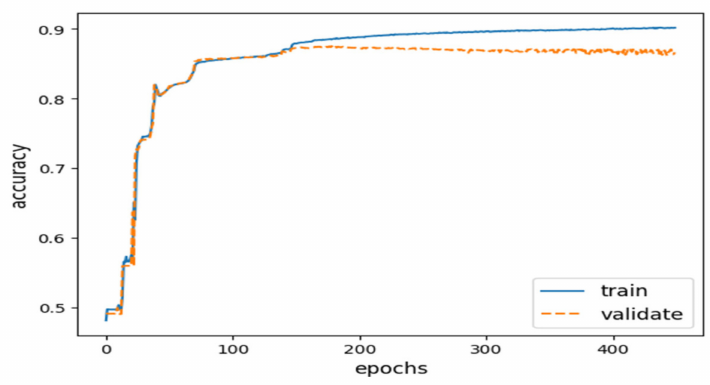
Figure 19. P-MLP training accuracy.